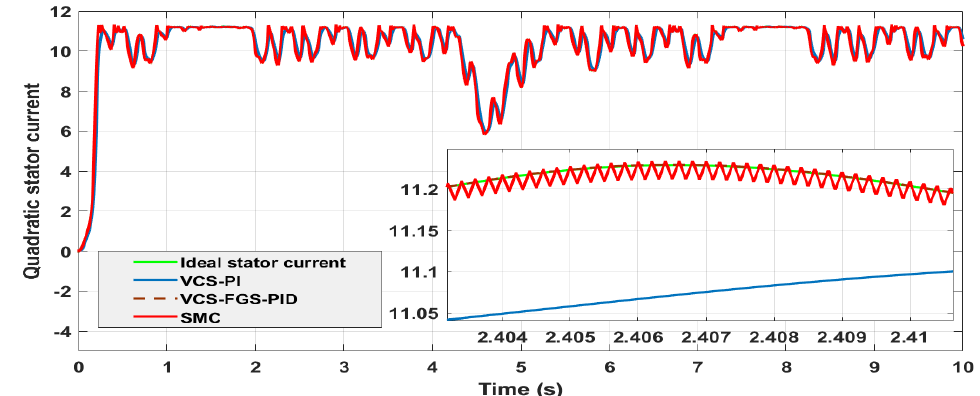
Figure 33. Quadratic stator current.